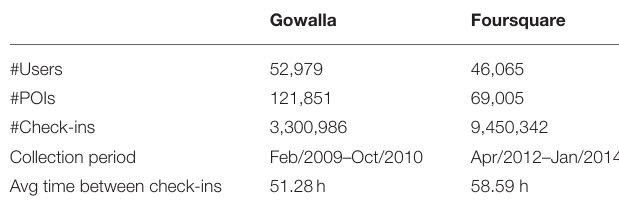
TABLE 1 | Gowalla and foursquare datasets